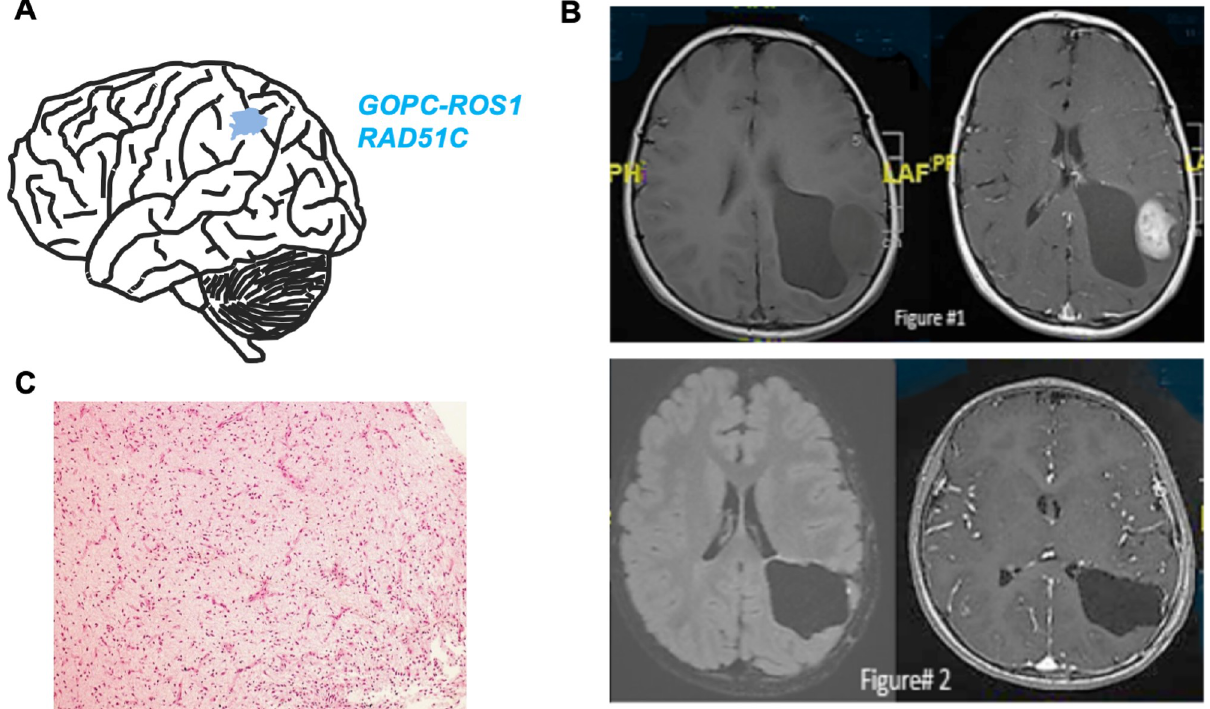
Fig 4. GOPC-ROS1 fusion and disease pathology. (a) Schematic of the tumor location and co-occurring mutations, (b-c) Postoperative MRI showing gross total surgical resection of the mass with no residual tumor identified. (d) Photomicrograph of an H&E-stained tumor section, demonstrating findings of low-grade glioma with a low to moderate cellularity, biphasic architecture, piloid and oligodendroglial tumor cells and Rosenthal